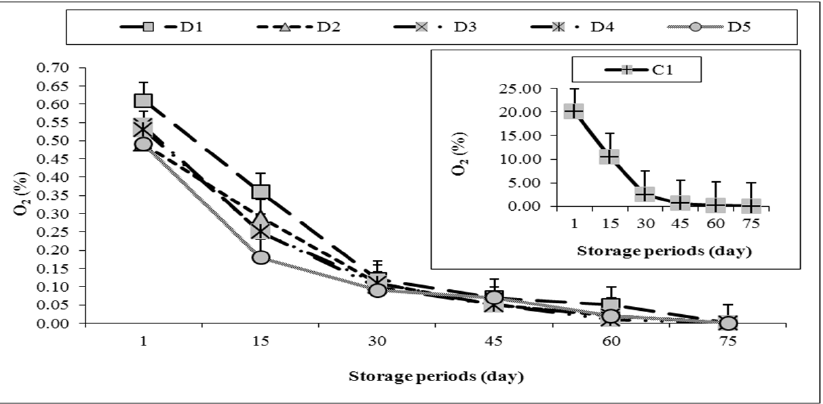
Figure 3. Levels of O 2 in the headspace of the Domiati cheese packaged under different modified atmospheres; C1, control packaged under aerobically atmosphere; D1, 10% CO 2 /90% N 2 ; D2, 15% CO 2 /85% N 2 ; D3, 25% CO 2 /75% N 2 ; D4, 100% CO 2 ; and D5, 100% N 2 . Data are presented as the means plus standard errors.